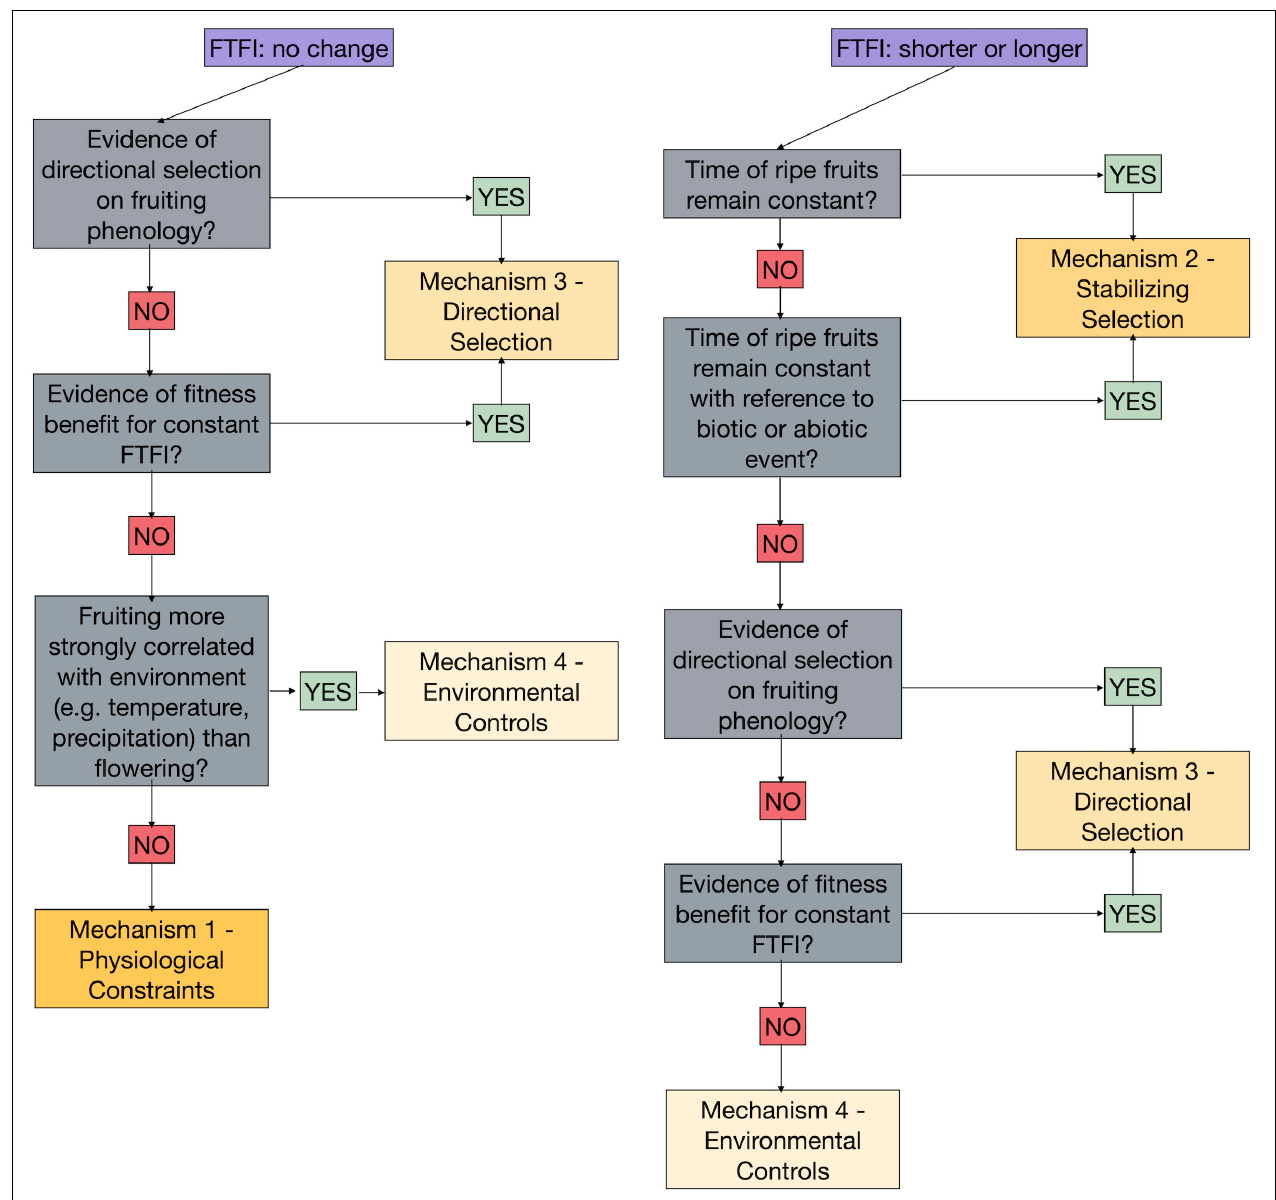
FIGURE 3 | Framework for using the observed changes, or lack thereof, in the flower to fruiting interval (FTFI) over time along with additional data and analyses to distinguish the underlying mechanism driving the FTFI. This flowchart only illustrates how the four general mechanisms can be distinguished. Ways to tease apart and eliminate the pathways through which each general mechanism could operate is described within the main text. The order shown here in which mechanisms can be progressively eliminated is suggested; there are multiple approaches to eliminating the possible mechanisms driving the FTFI. For example, directional selection could be eliminated after environmental controls or before stabilizing selection for the absence of a change or a lengthening or shortening of the FTFI,